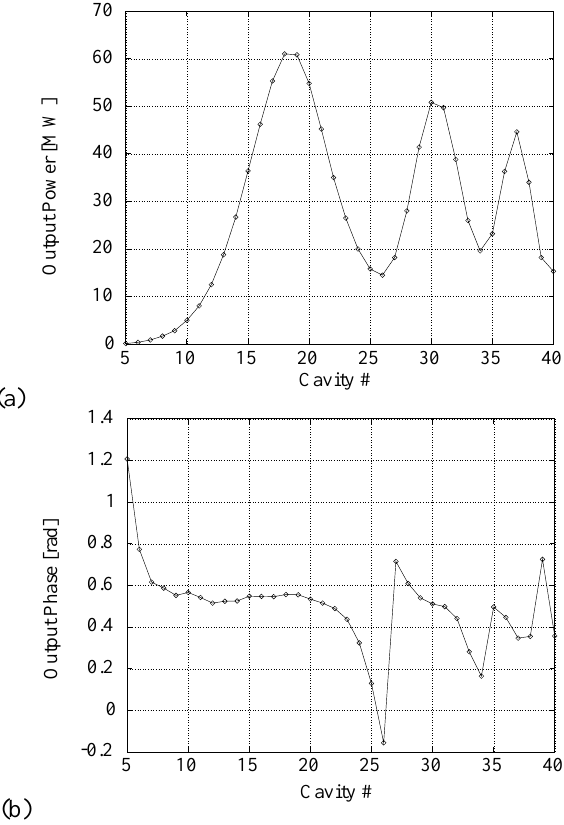
FIG. 18. Current (a) and bunching parameter (b) evolution in the afterburner configuration. FIG. 19. Steady-state output power (a) and phase (b) in the